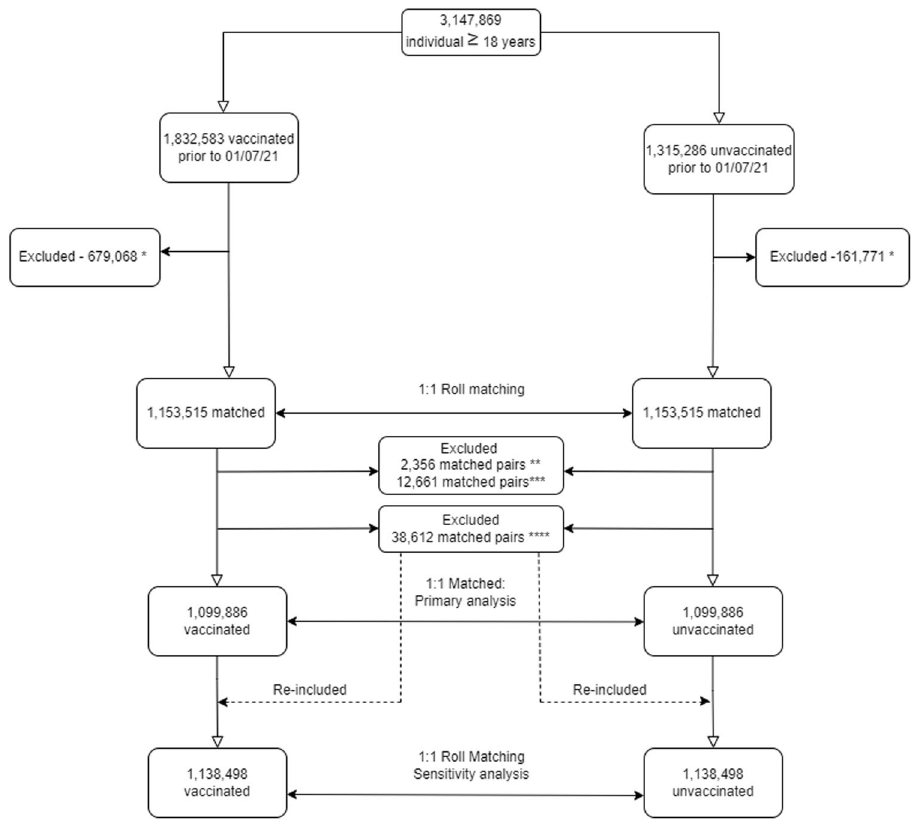
Fig. 1 Flowchart of study population and matching process. *Were not matched. **Vaccinated individuals with the interval between 1st and 2nd dose less than 2 weeks. Their corresponding matched unvaccinated individuals were also excluded. ***Individuals (Vaccinated & Unvaccinated) who had hospital admission prior to their baseline dates. Their corresponding matched individuals (Vaccinated & Unvaccinated) were also excluded. ****Unvaccinated individuals who received their fi rst dose of the vaccine during their follow-up period (i.e. after their baseline date). Their corresponding matched vaccinated individuals were also